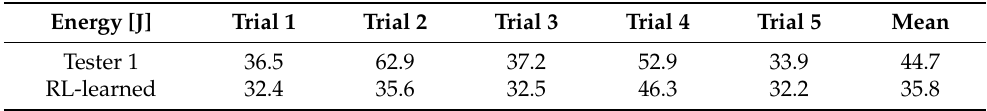
Table 5. The energy consumption of the RL-learned trajectories using initial via points selected by Tester